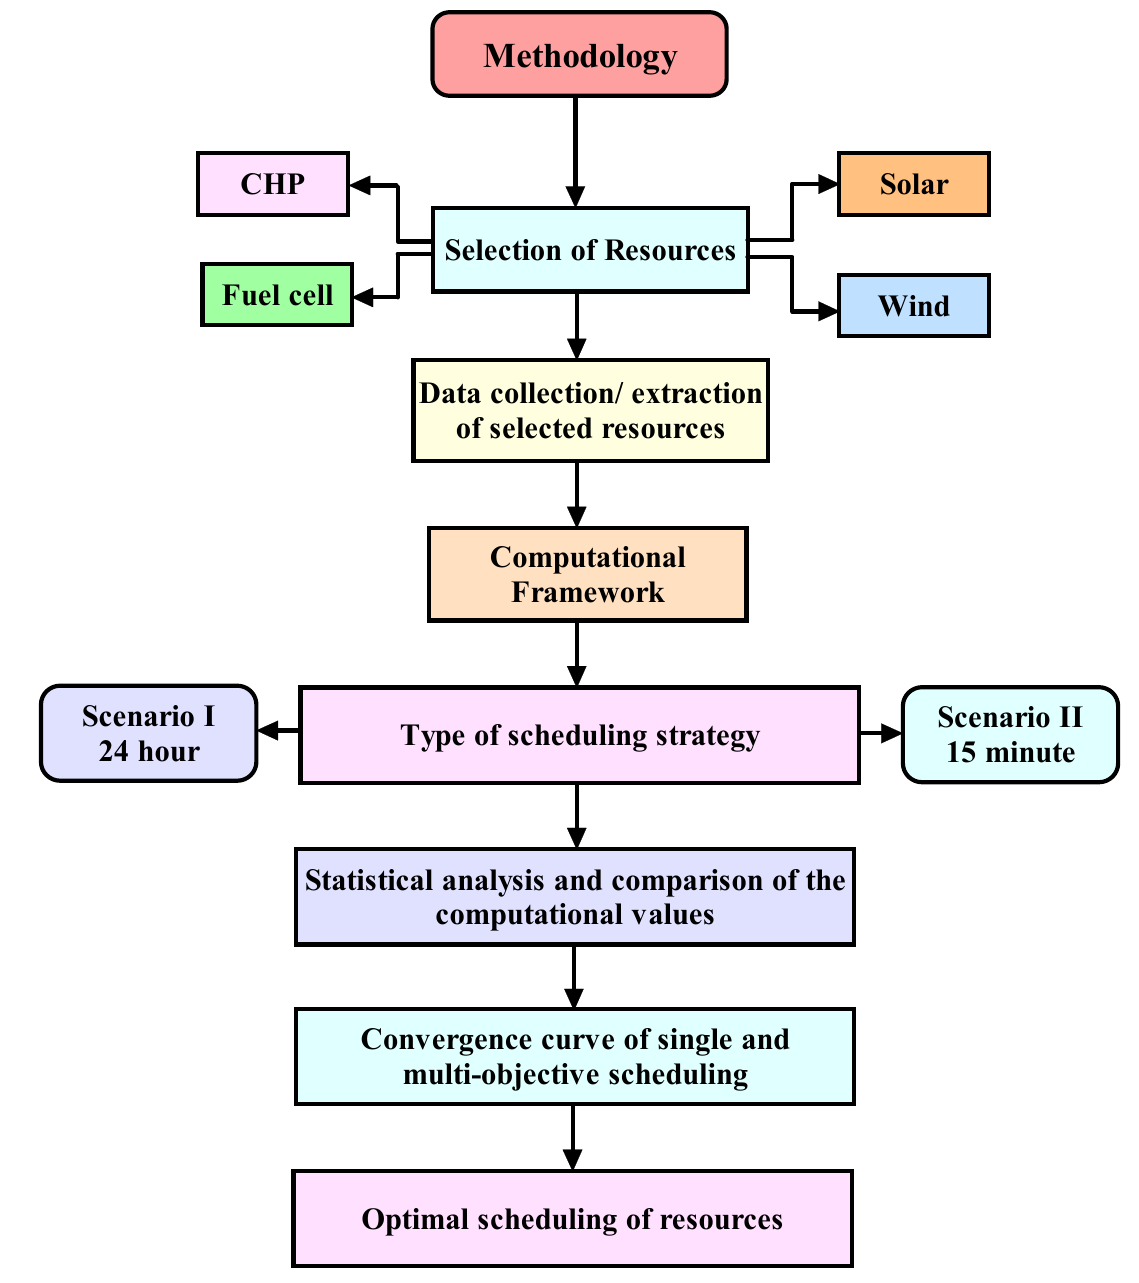
Figure 3. Methodology and process flow of the proposed strategy.